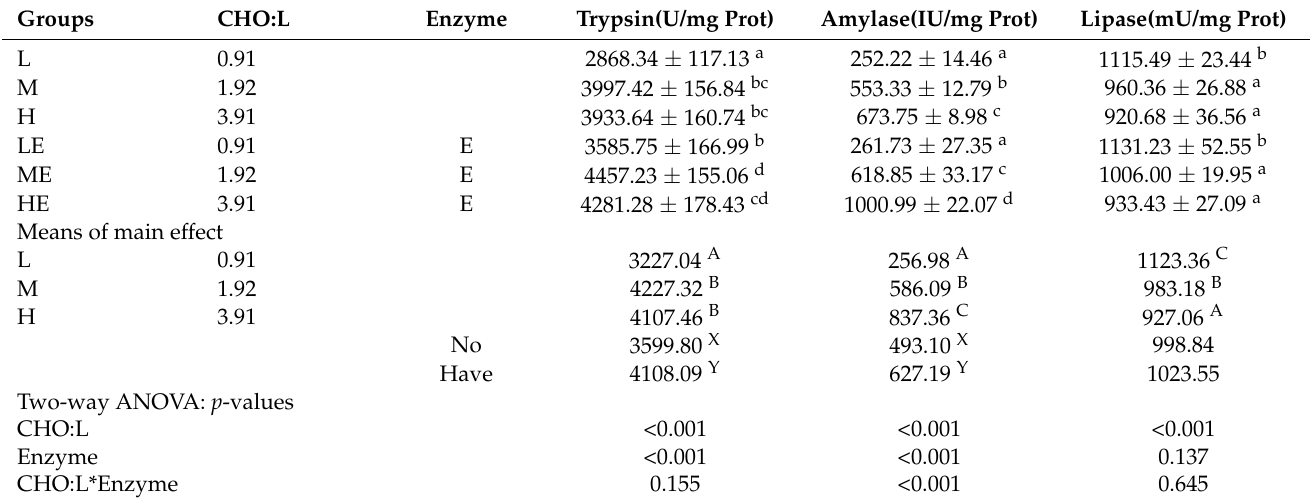
Table 6. Effects of carbohydrase supplementation on intestinal digestive enzymes in hybrid grouper fed different CHO:L ratios